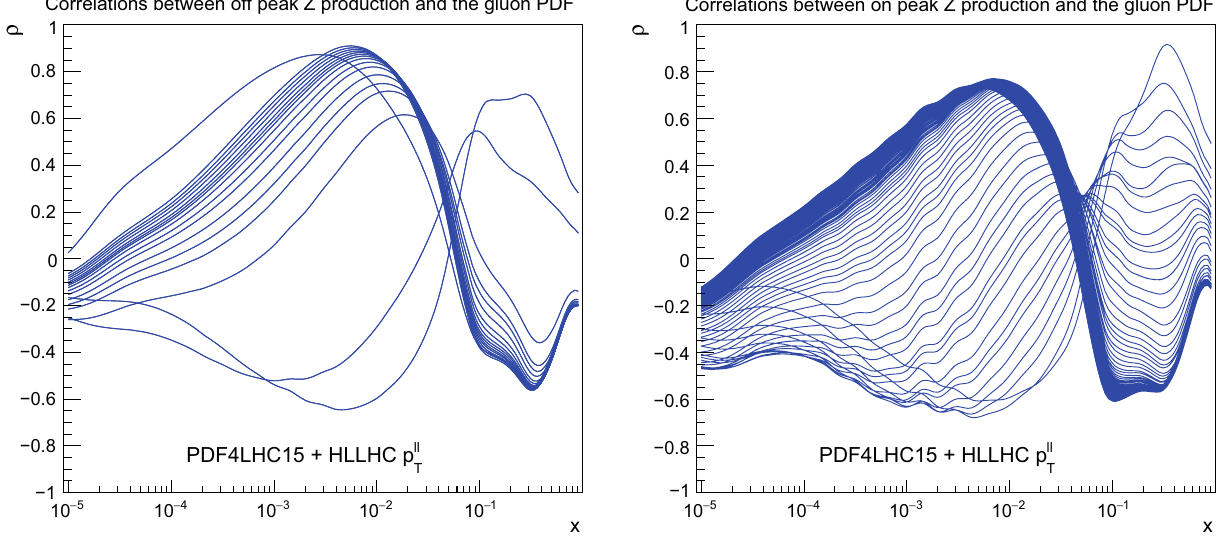
Fig. 15 As in Fig. 4, now for the correlation coefficients between the gluon PDF and the Z transverse momentum distributions in the central rapidity region, for the dilepton invariant mass 10GeV ≤ m ll ≤ 20 GeV (left plot) and 66GeV ≤ m ll ≤ 116 GeV (right plot)